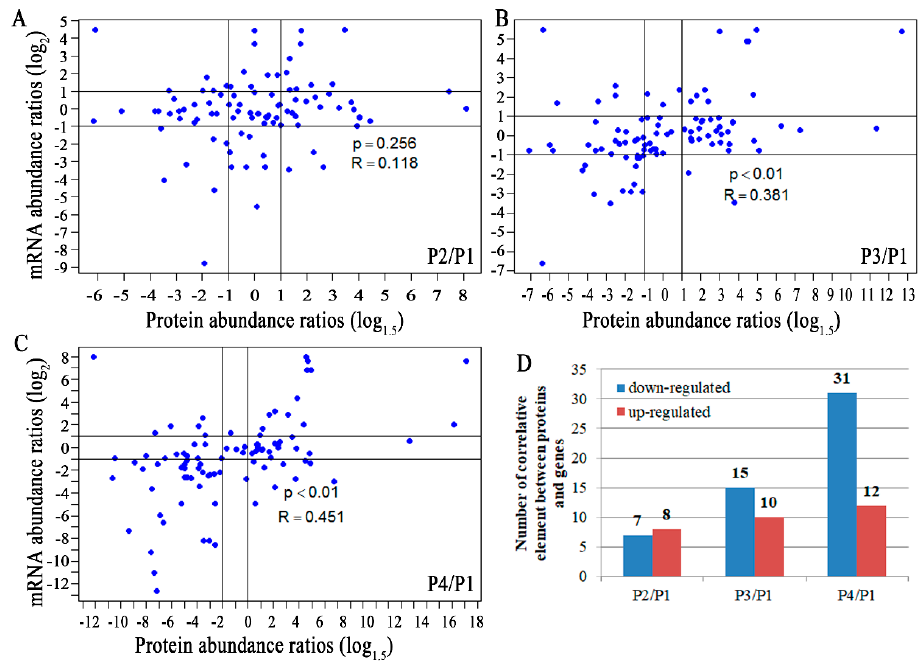
Figure 7. mRNA abundance ratios versus protein-abundance ratios. Ninety-four differentially expressed proteins and their corresponding genes were analyzed. The log 2 ratio of P2, P3, P4 to P1 at the mRNA level and the log1.5 ratio at the protein level were plotted against each other for each unique gene. The number of the correlative element between proteins and genes was counted and shown in the A , B , and C histogram. D , statistical count of up- or down-regulated elements between proteins and genes.